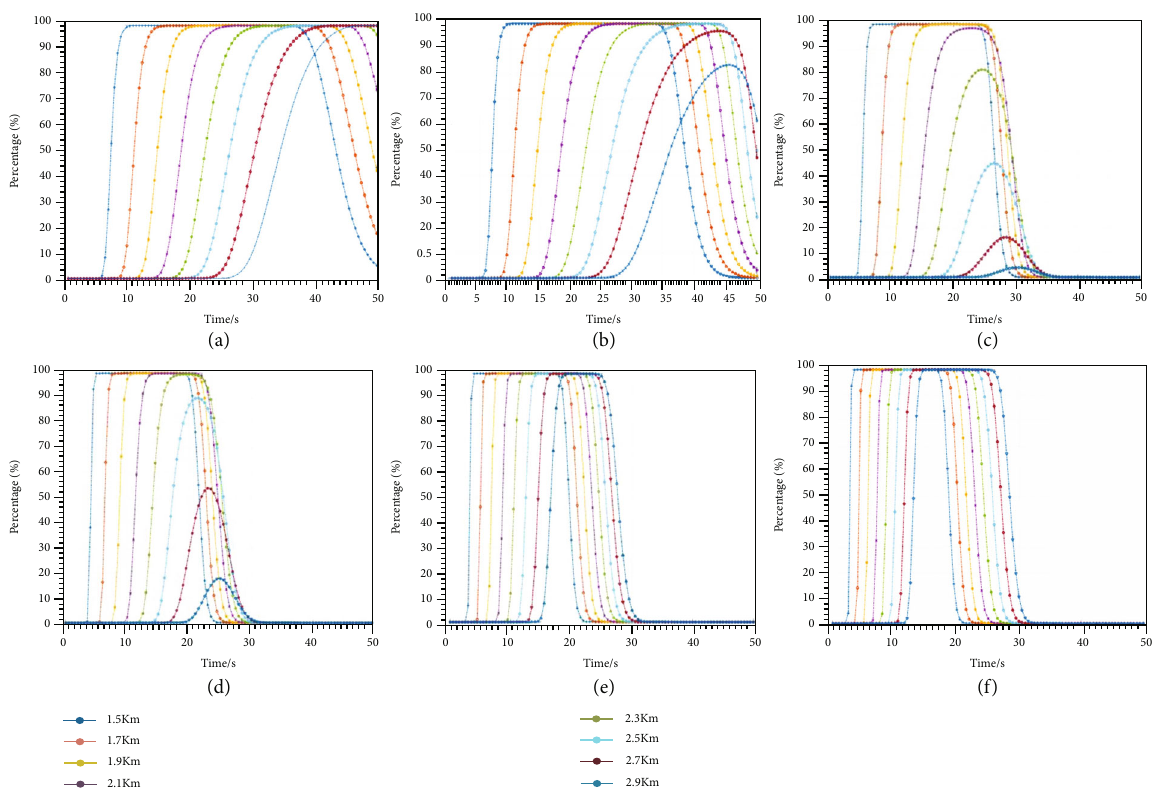
Figure 8: Con fl ict risk assessment of horizontal fl ight in low-level airspace ( flight altitude < 1000m ) versus steer angle d ∈ ½ 1 : 5, 2 : 9 Km (cid:2) , H = 0 , θ = θ = 0 , V = 360Km/h , and V = 169Km/h . Results are averaged over 1000 simulations. (a) θ = π /9 ; (b) θ = π /6 ; 3MAV 3UAV MAV UAV (c) θ = π /3 ; (d) θ = π /2 ; (e) θ = 2 π /3 ; (f) θ = 8 π /9